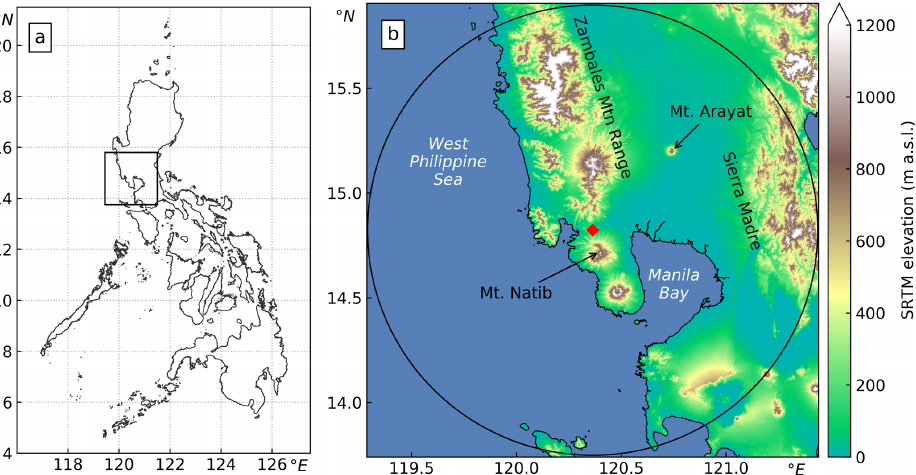
Figure 1. (a) Map of the Philippines showing the region of study and (b) the 120km coverage of the Subic radar (location marked with a red diamond) with the SRTM digital elevation model of the surrounding area.